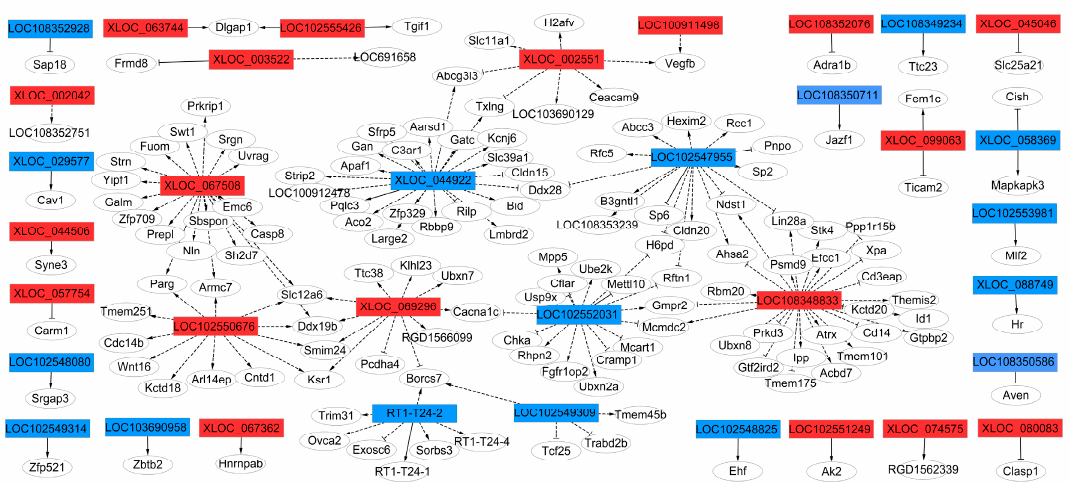
Figure 6. The co-expression network of LncRNA-target genes network. The co-expression network comprised 36 highly conserved lncRNAs and 146 mRNAs. The rectangles represent lncRNA, the circles represent target gene mRNAs. The red represents up regulated lncRNA, and blue represents down regulated lncRNA. The solid line represents cis-regulated targets, the marquee dash line represents trans-regulated targets. The delta target arrow shape represents positive correlation, the T target arrow shape represents negative